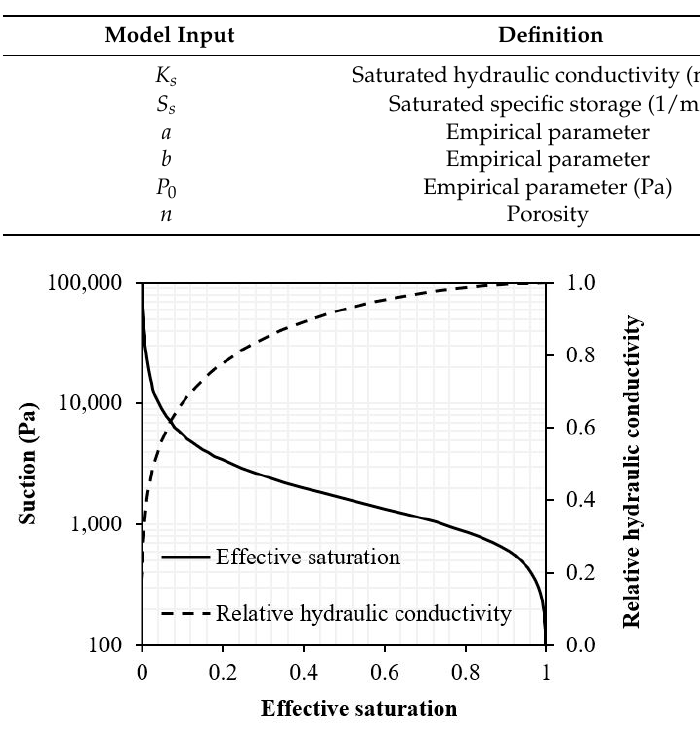
K of the soil. Figure 3. SWCC and relative hydraulic conductivity K r , of the r